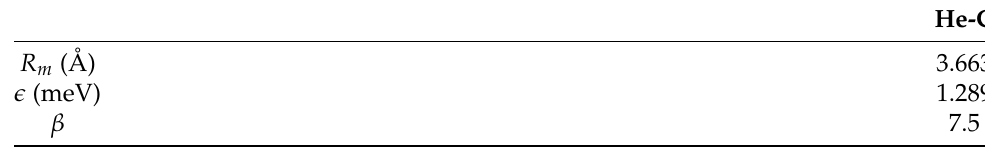
Table 1. Parameters of atom-atom Improved Lennard-Jones (ILJ) Potential for the interaction of He with graphtriyne